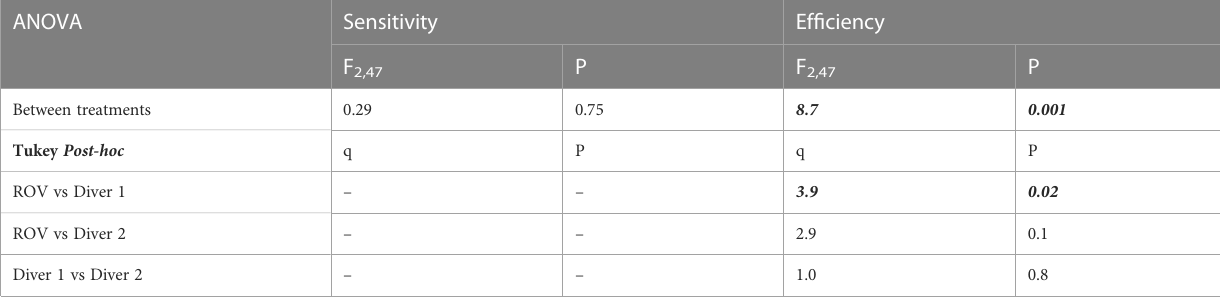
TABLE 2 Variation in sensitivity and detection rates between methods (including between divers) as analysed using one-way ANOVA, and post-hoc Tukey tests. ANOVA